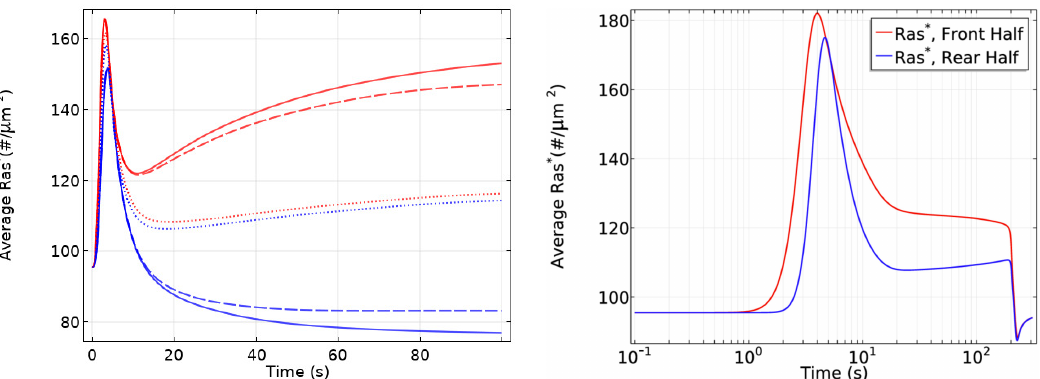
Figure 21. ( Left ) The effect of diffusion on the biphasic response. Solid, dashed and dotted lines are for D = 0, 0.1 and 10 µ m 2 /s resp.—cytosolic diffusion of all components: D = 30 µ m 2 /s. ( Right ) The average Ras* in the front and rear halves in response to a passing triangle wave. From Cheng and Othmer [133].